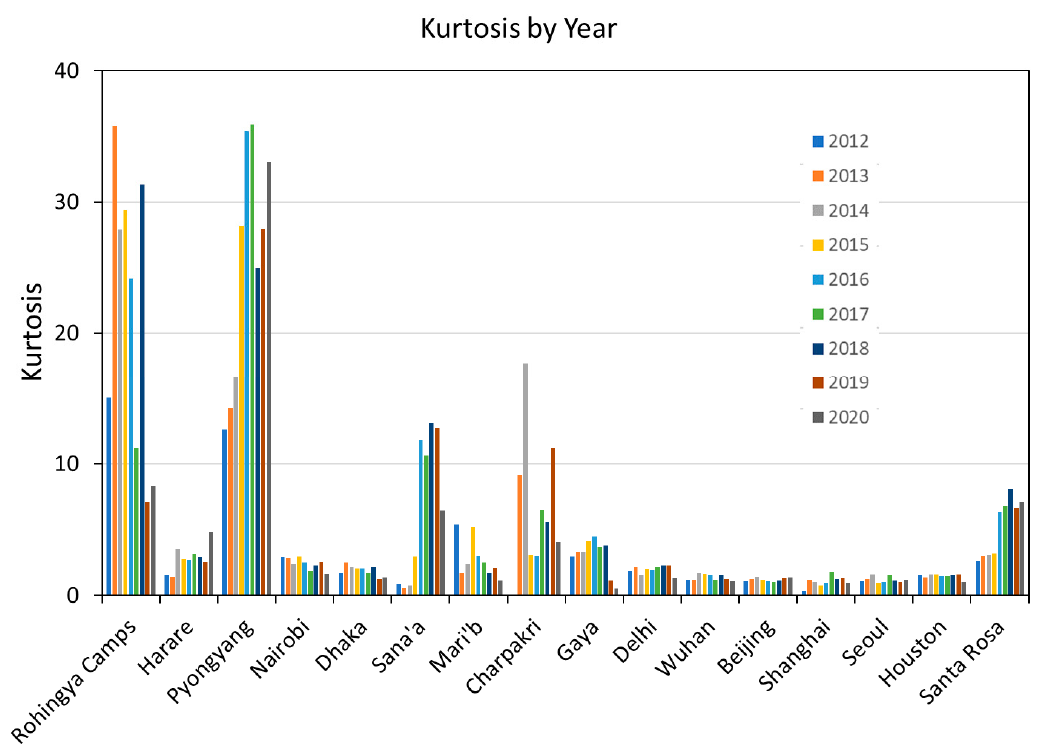
Figure 26. Picket-fence chart of the mean kurtosis for each of the test sites by year.